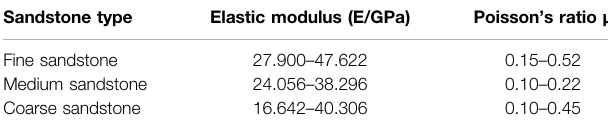
TABLE 3 | Young ’ s modulus and Poisson ’ s ratio of different types of